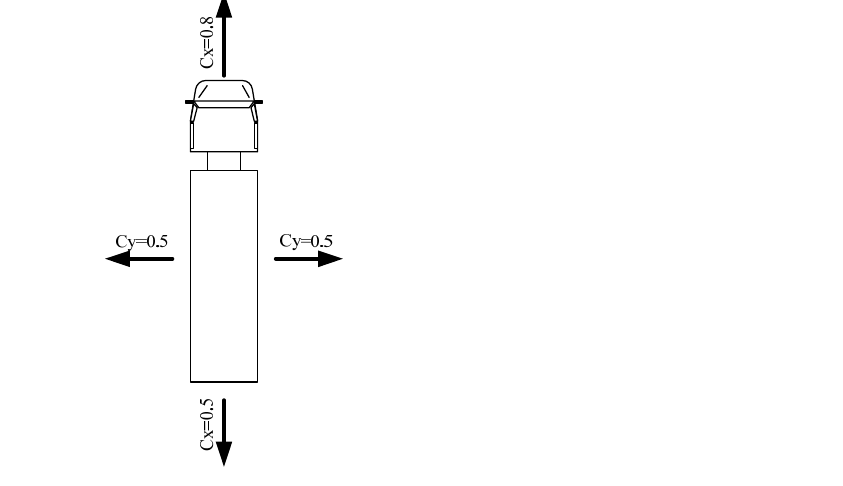
Figure 1. Acceleration coefficients used in road transport.